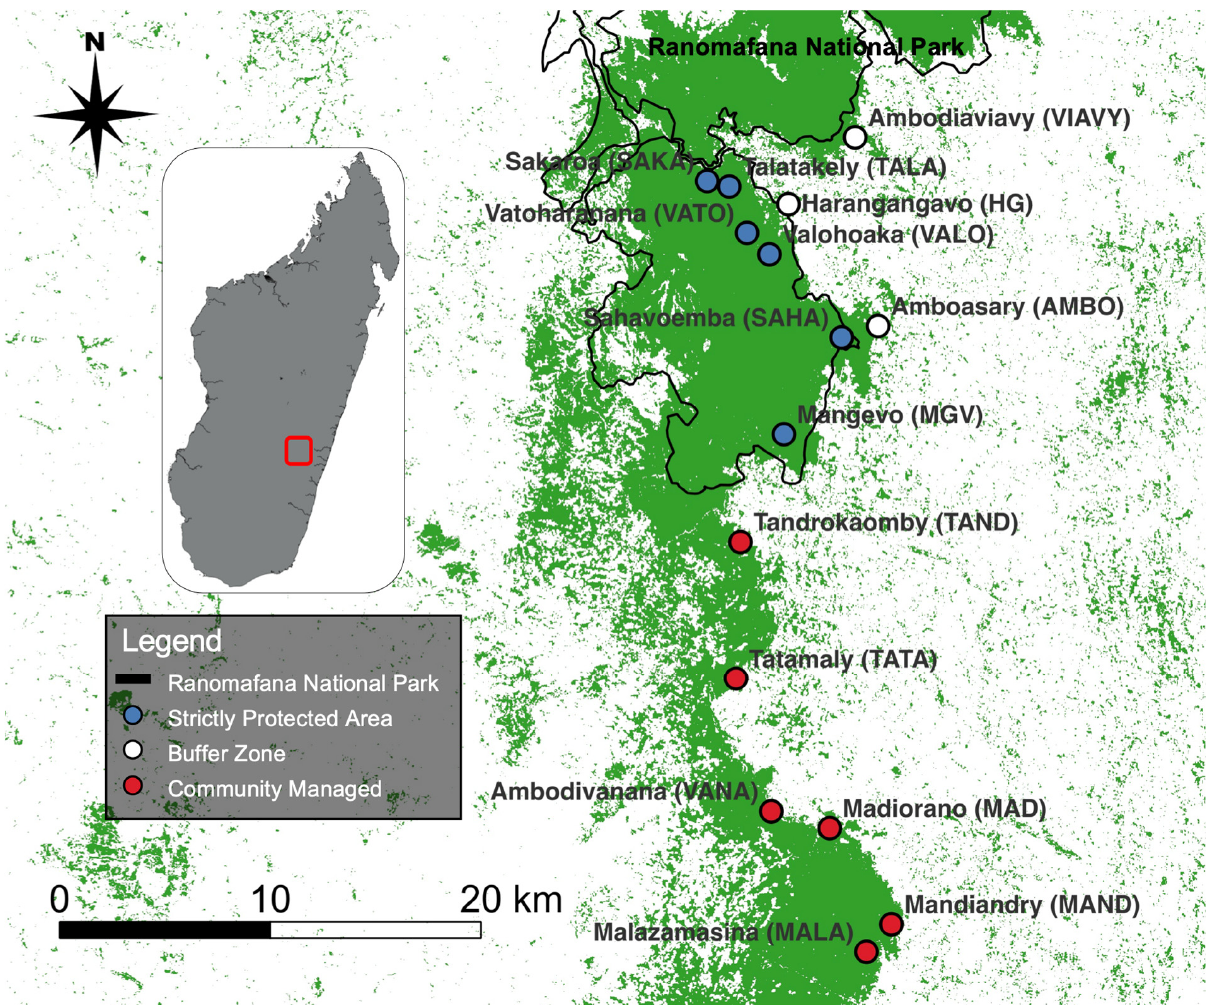
Figure 1. Map illustrating sampling localities ( n = 15) across Ranomafana region with protection status noted. GIS layers courtesy of Gerber [79] and Hijmans et al. [80].